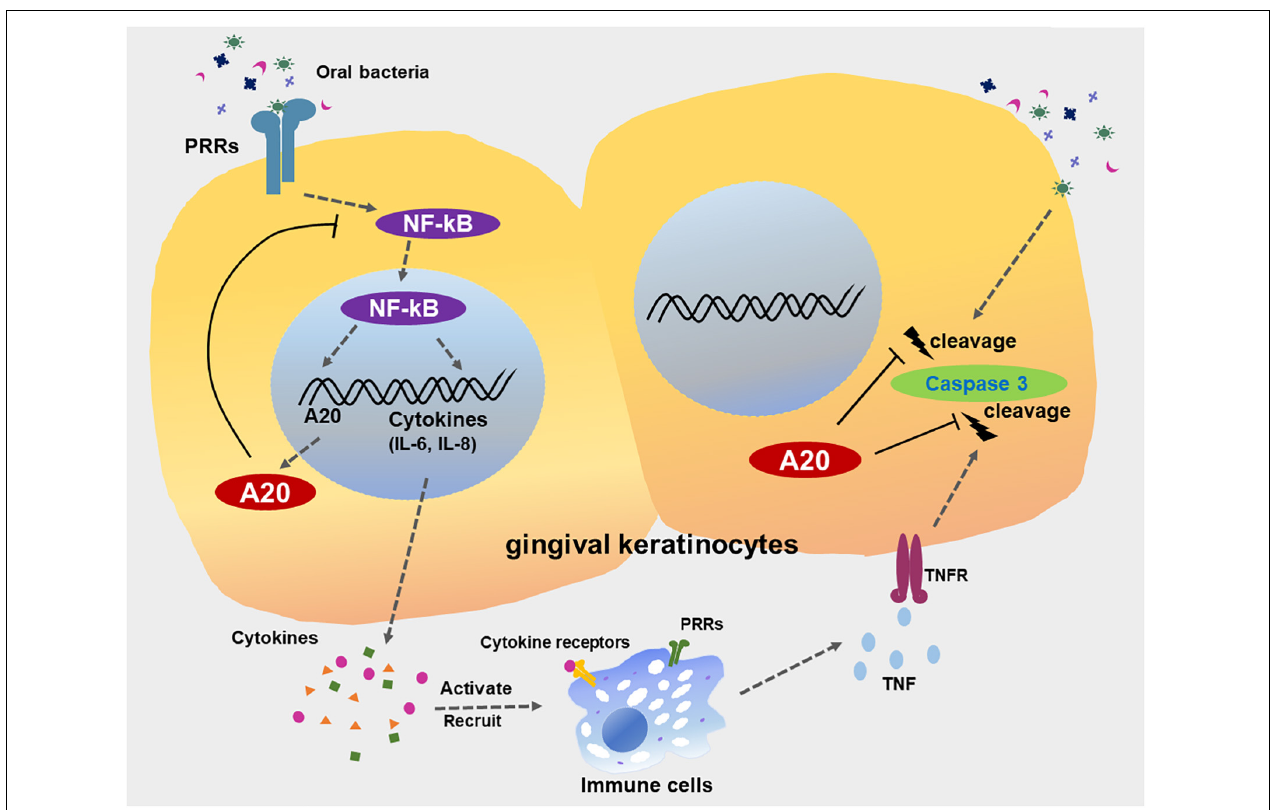
FIGURE 9 | A20 restricts inflammatory responses and apoptosis in gingival keratinocytes. The engagement of microbial ligands with pattern recognition receptors (PRRs) on the surfaces of gingival keratinocytes initiates the activation of the NF- κ B signaling cascade, promoting the production of downstream pro-inflammatory cytokines and chemokines, such as IL-6 and IL-8. Activation of NF- κ B also induces the dramatic increase in A20 expression, resulting in a negative feedback loop responsible for the de-activation of NF- κ B signaling and a return to oral mucosal tissue homeostasis. However, a failure to resolve inflammation results in the aberrant production of inflammatory mediators, which induce the rapid migration of more immune cells to the site of infection. These inflammatory processes could also drive neighboring cells to apoptosis, mediated primarily by further bacterial invasion and activation of several receptors including TNFR, thus contributing to the development of chronic inflammation seen in periodontitis. A20 subsequently restricts caspase 3 cleavage, thereby desensitizes gingival keratinocytes from apoptosis. Collective function of A20 facilitates the preservation of oral tissue homeostasis and maintenance of epithelial